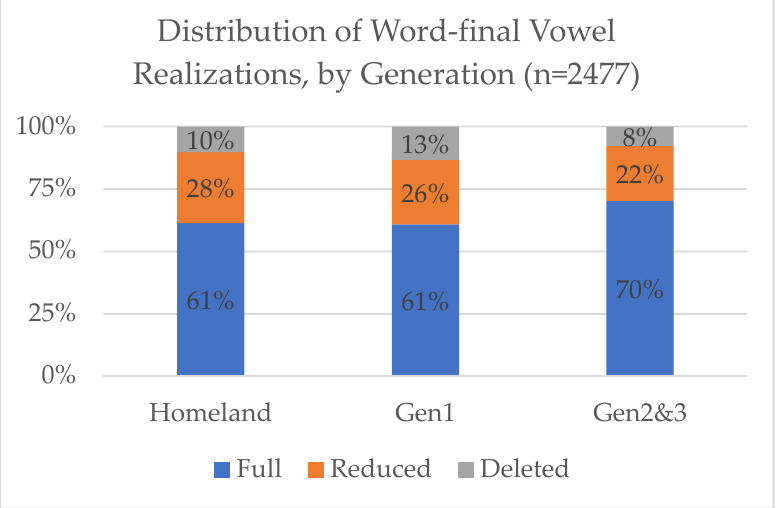
Figure 1. Distribution of vowel realizations by generation.